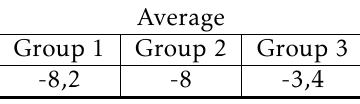
Table 2. Standard deviation of gradients.